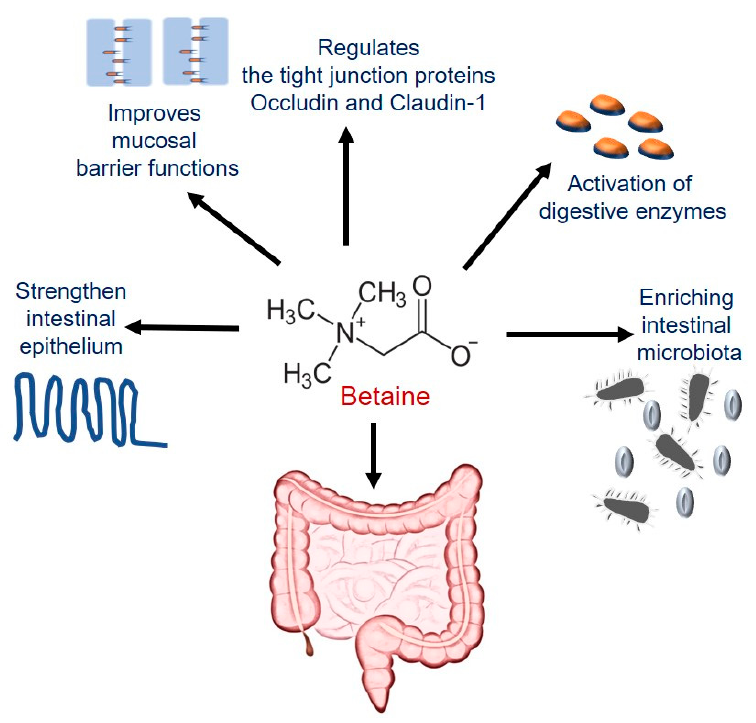
Figure 4. Schematic representation for the functions of betaine in the intestine.